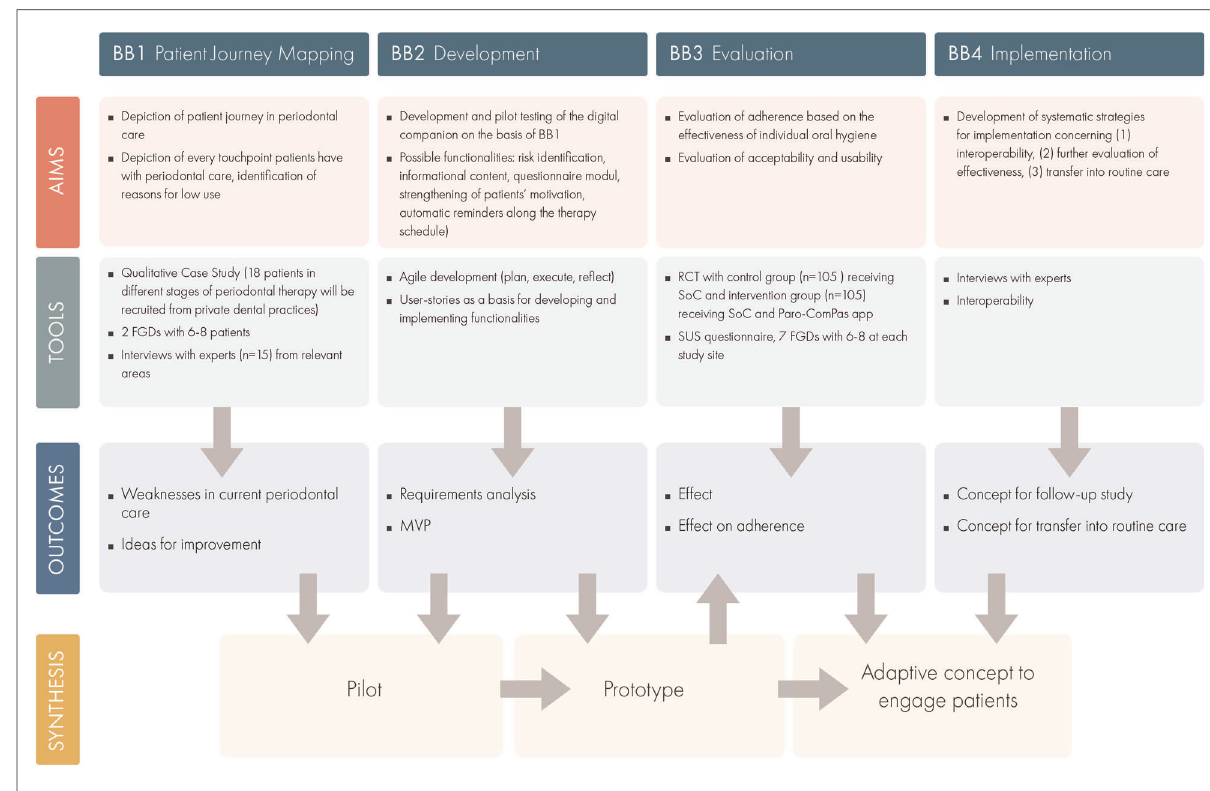
FIGURE 1 Overview of the building blocks and the study